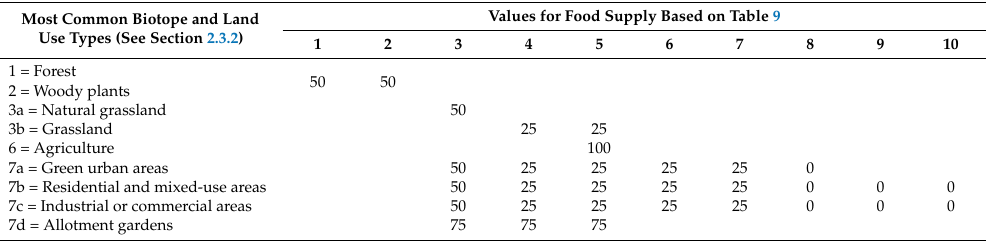
Table 13. Index values for food supply for the most common biotope or land use type and each hemeroby degree. Value 100 = highest ecosystem service capacity; 0 = lowest/no ecosystem service